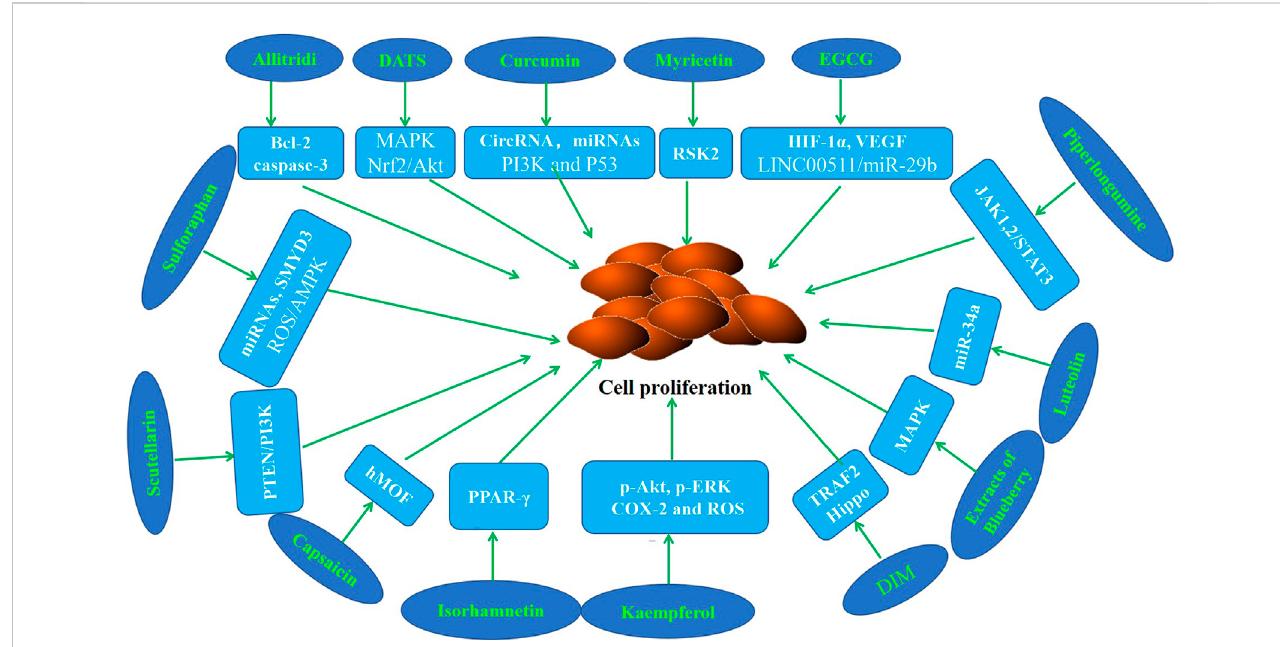
FIGURE 2 Molecular mechanism of anti-GC effect of representative phytochemicals by inhibiting cell